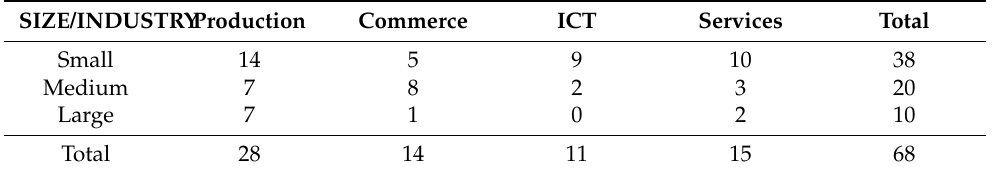
Table 6. Distribution of companies concerning size and industry.